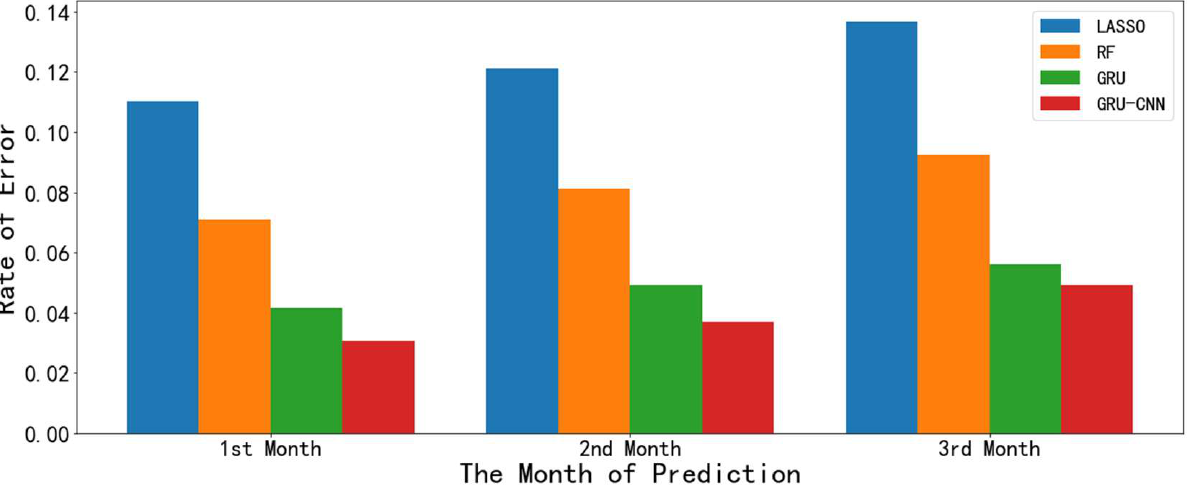
Figure 10. The average rate of error in the prediction of drought classification in the next three months at LinCang.